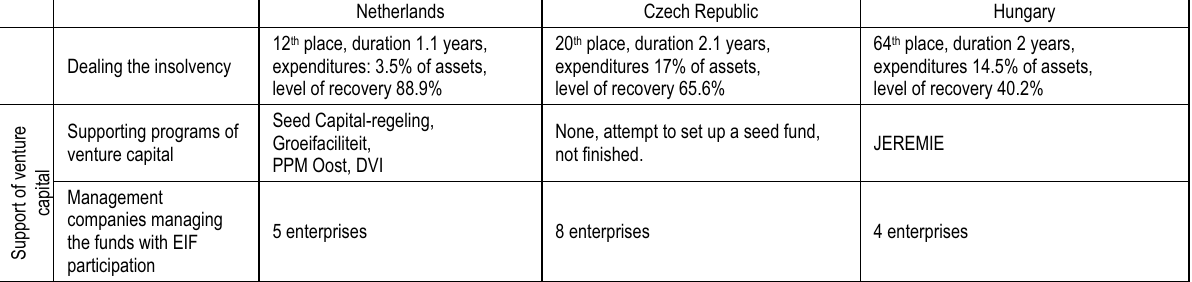
Table 3 (cont.). Results of comparative study: the Czech Republic, the Netherlands and